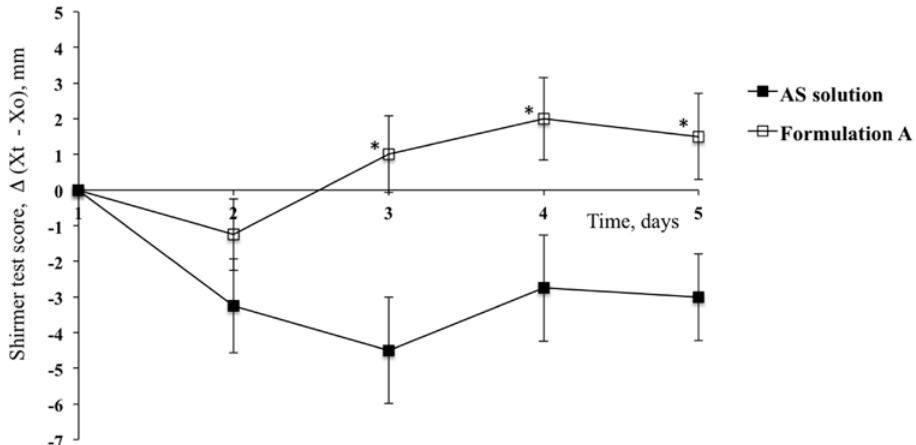
Figure 4. Shirmer Test Scores for the group of rabbits treated with Formulation A and for contralateral eyes (Reference) after treatment with AS solution. (Means ± SE, n = 6). * Statistically significant different from the STS calculated for the contralateral eye ( p < 0.05, t -test).